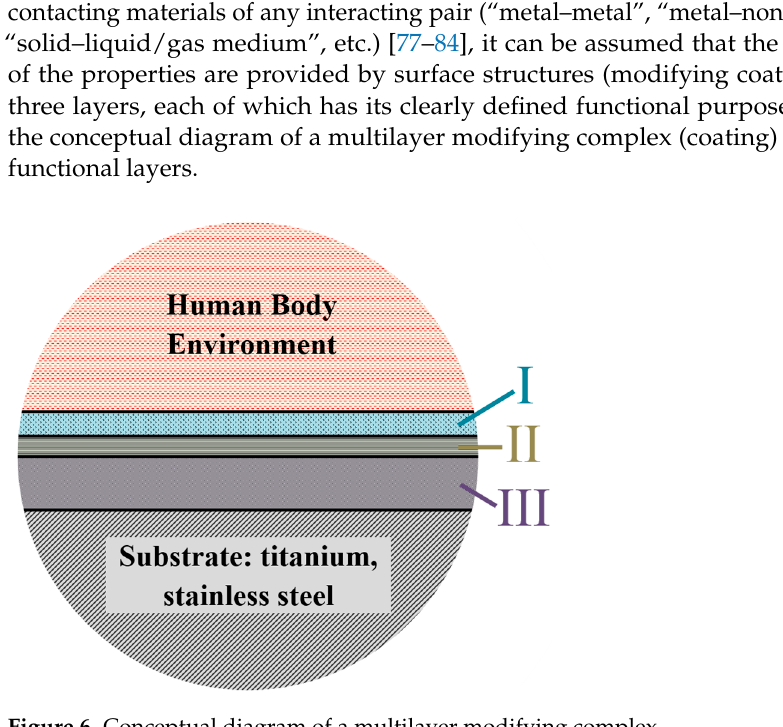
Figure 6. Conceptual diagram of a multilayer modifying complex.